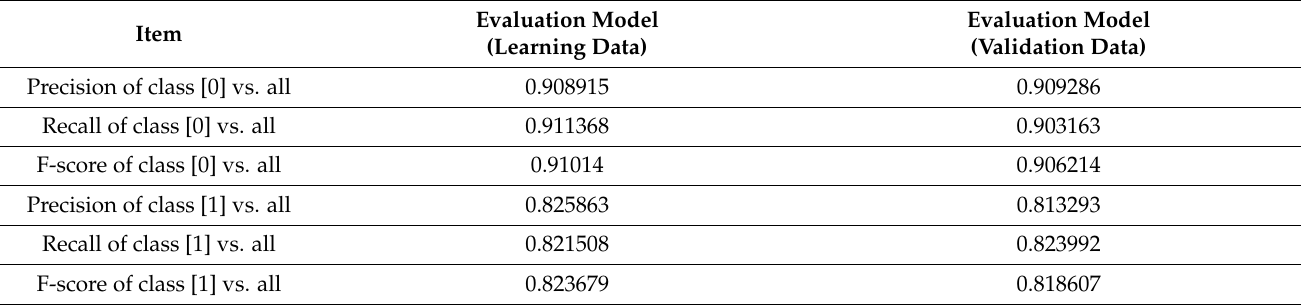
Table 2. Accuracy evaluation of asbestos-cement corrugated roofing tiles classified results with